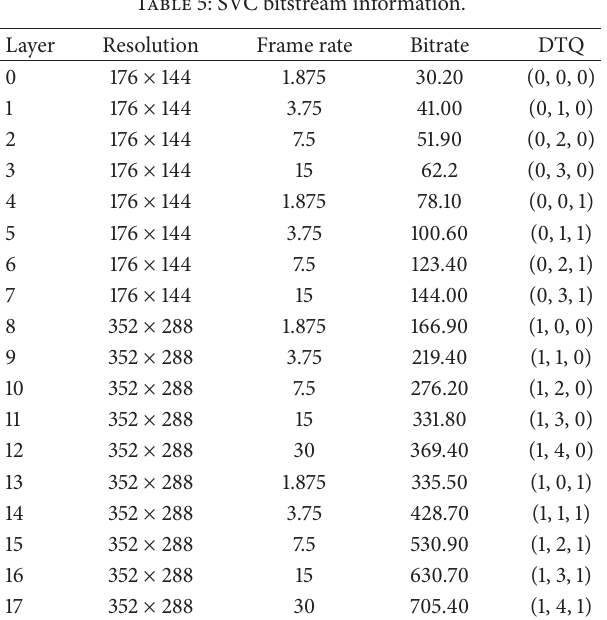
Table 5: SVC bitstream information.